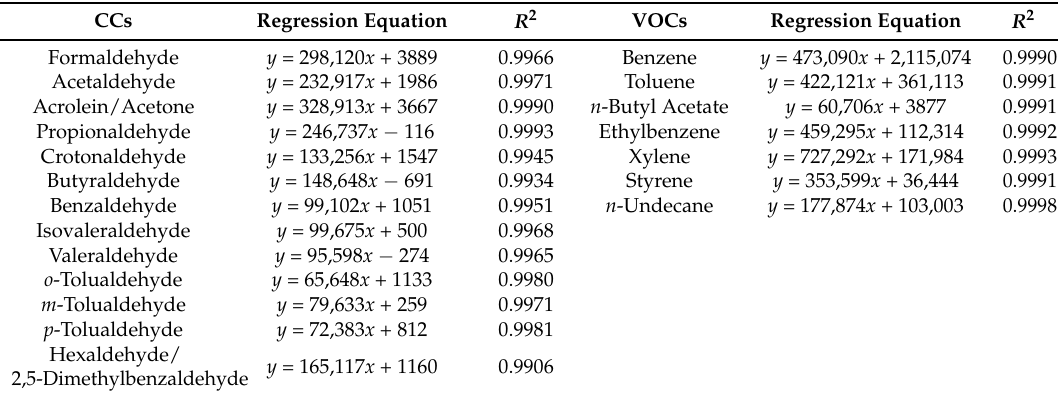
Table 3. The linearity data for VOCs and CCs.